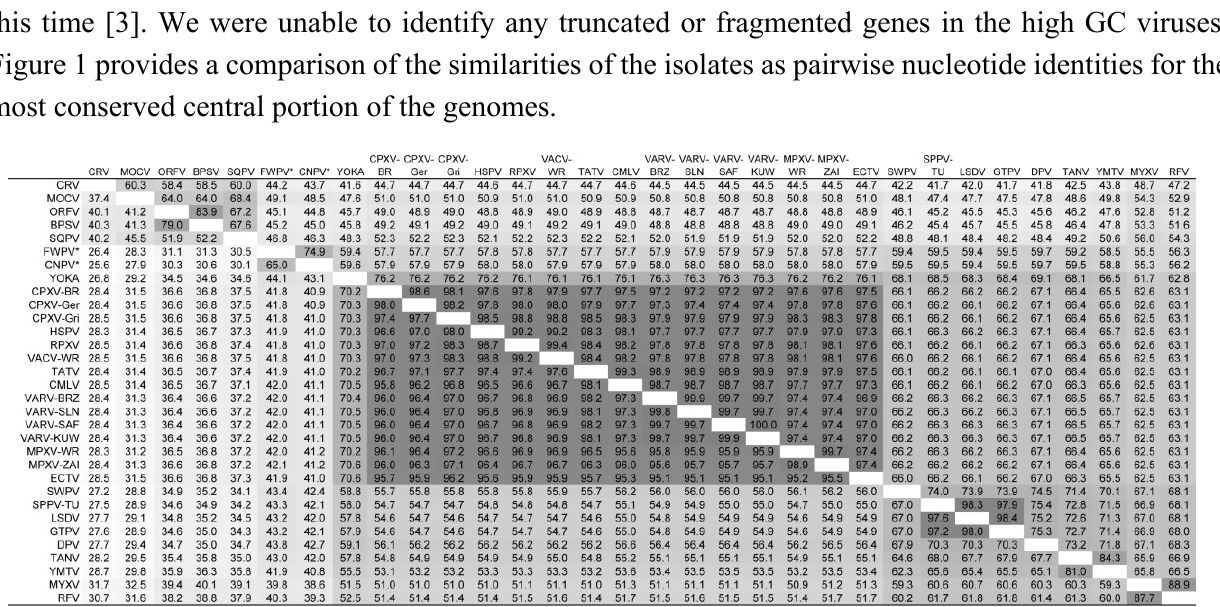
Figure 1. Pairwise nucleotide % identities for the conserved central region of the poxvirus isolates used in this study. Values below the diagonal included gaps when calculating the pairwise identity, whereas values above the diagonal had all gapped columns removed before analysis. The conserved central region spans the genomic sequences from Cop-F9L (CPXV-Ger position 52,398) to Cop-A34R (CPXV-Ger position 160,094). Darker shading reflects higher levels of identity. *FWPV and CNPV, contain a genome inversion in this region, and therefore their sequences were rearranged in order to align them with the other